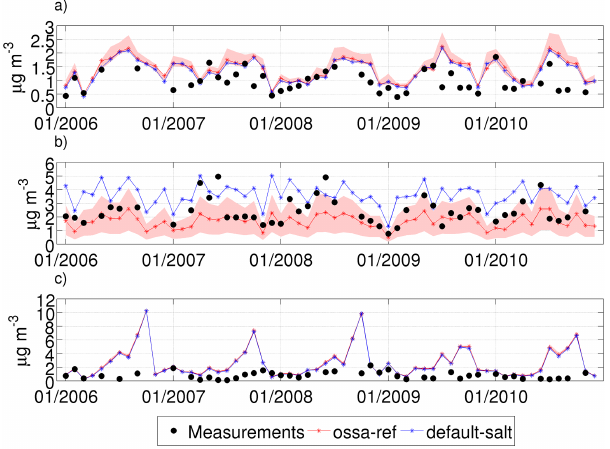
Figure 8. Measured and modelled monthly mean PM 2.5 mass con- centration of (a) sulfate, (b) sea salt and (c) organic matter at Point Reyes. The shaded area around the red line corresponding to simu- lation ossa-ref represents the uncertainty from the sensitivity